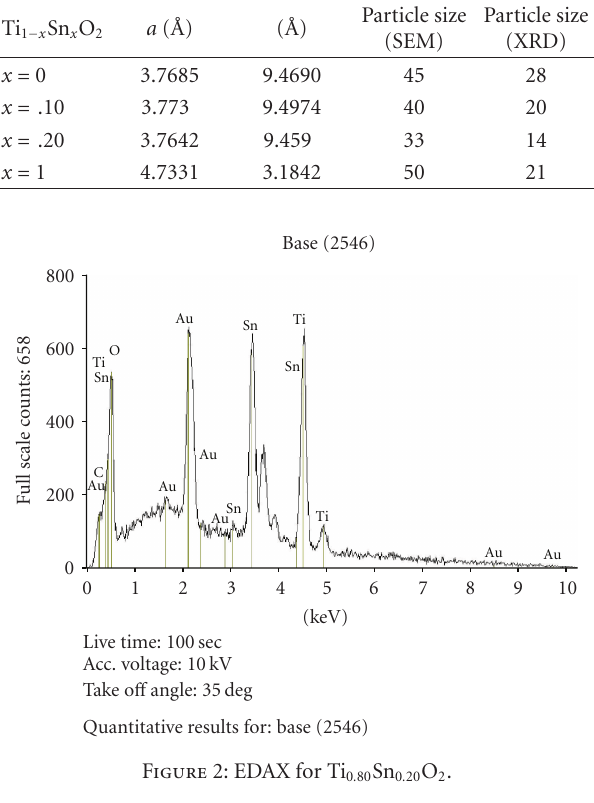
Figure 2: EDAX for Ti 0 . 80 Sn 0 . 20 O 2